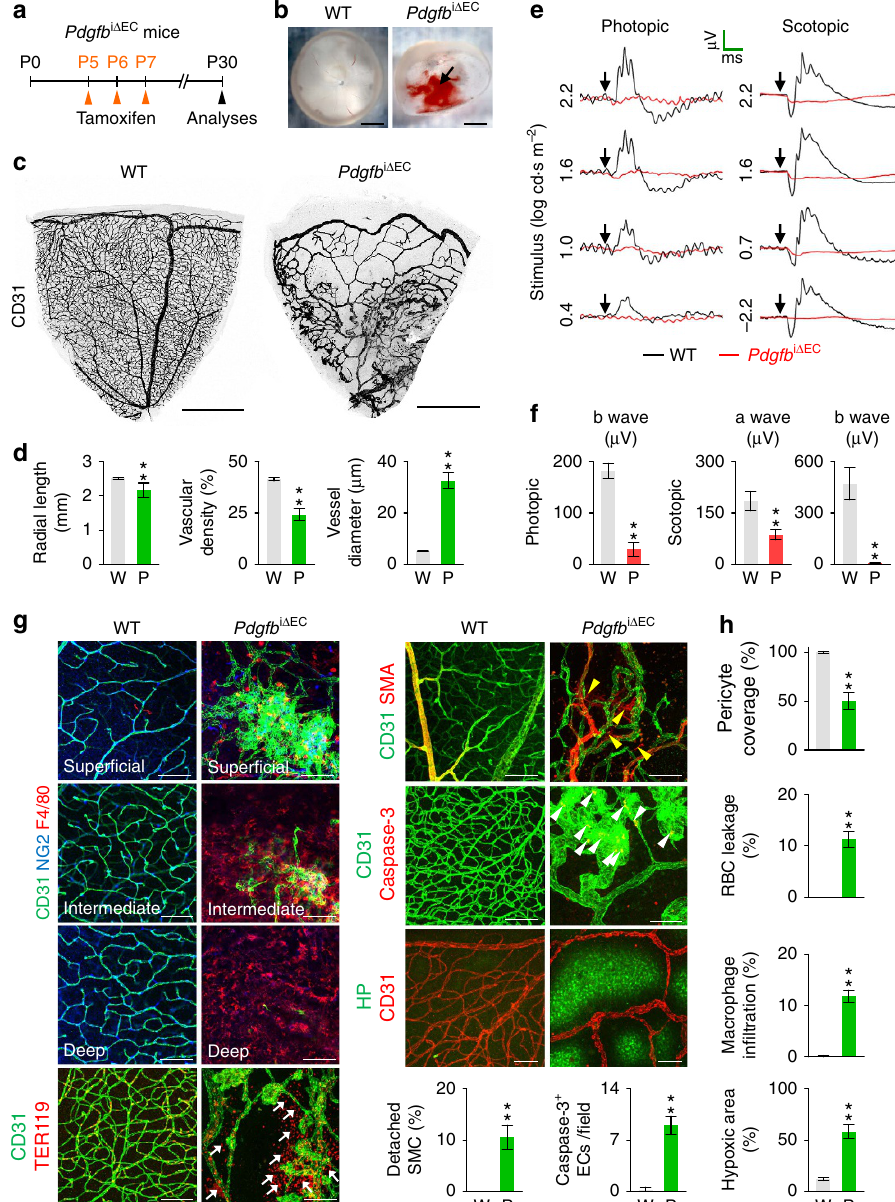
Figure 2 | Inadequate pericyte coverage impairs BRB and vision. ( a ) Diagram depicting the experiment schedule for EC specific deletion of PDGF-B in retinal vessels from P5 and their analyses at P30 in Pdgfb i D EC mice. ( b , c ) Images of inner surface and vascular plexus in retinas of WTand Pdgfb i D EC mice. Vitreous hemorrhage (arrow) and severely impaired vascular network are detected in Pdgfb i D EC mice. ( d ) Comparisons of indicated parameters in WT (W; n ¼ 6) and Pdgfb i D EC (P; n ¼ 6) mice. ( e ) Electroretinography in WTand Pdgfb i D EC mice. Normal ERG responses showing photopic b wave and scotopic a and b waves in WTmice (black line) are hardly detected in Pdgfb i D EC mice (red line). Arrows, flash stimuli. Scale bars (green), 40ms ( x ) and 40 m m ( y ) in photopic ERG, 40ms ( x ) and 160 m m ( y ) in scotopic ERG. ( f ) Comparisons of amplitude of photopic b wave and scotopic a and b waves by the stimulus of 1.6logcdsm (cid:2) 2 in WT (W; n ¼ 6) and Pdgfb i D EC (P; n ¼ 6) mice. ( g ) Images showing impaired CD31 þ vascular plexus in superficial, intermediate and deep layers, enlarged CD31 þ vessels, detached or no NG2 þ pericyte coverage, abundant F4/80 þ macrophage infiltration and TER119 þ RBC leakage (arrows), severe hypoxia, detached SMA þ SMCs from the CD31 þ vessels (yellow arrowheads), and caspase-3 þ apoptotic ECs (white arrowheads) are largely detected in retinas of Pdgfb i D EC mice compared with those of WT mice. HP, hypoxyprobe. ( h ) Comparisons of indicated parameters in WT (W; n ¼ 6) and Pdgfb i D EC (P; n ¼ 6) mice. Error bars represent mean ± s.d.** P o 0.01 versus WT by Mann–Whitney U test. Scale bars, 100 m m (white) and 500 m m (black). NATURE COMMUNICATIONS|8:15296|DOI: